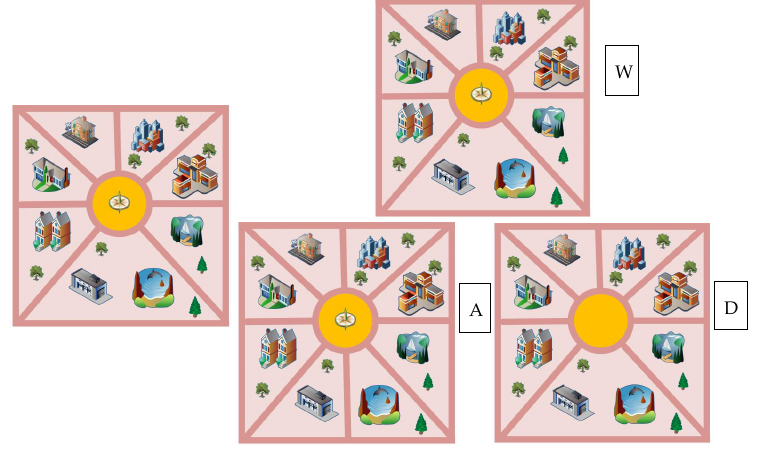
Figure 2. Spatial memory experimental